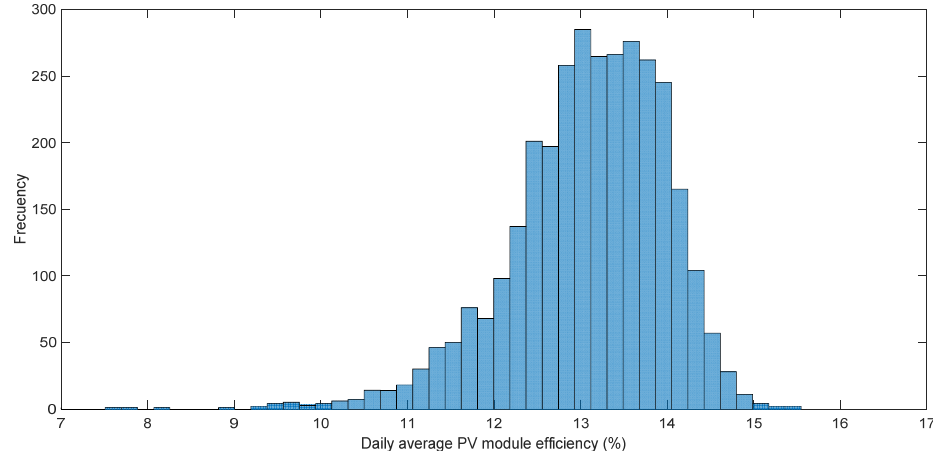
Figure 3. Histogram corresponding to the daily average efficiency values of PV modules during the period 2011–2020.